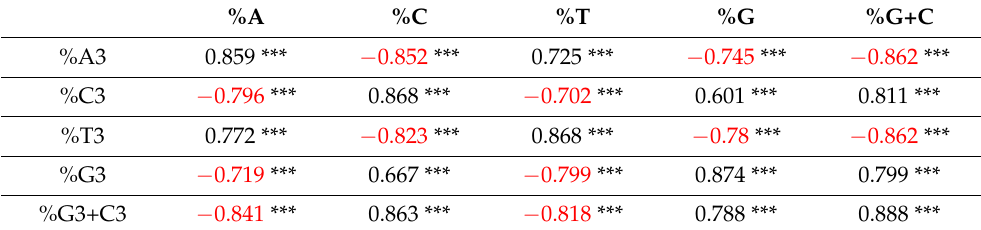
Table 4. Correlation analysis for overall nucleotide composition with composition at third codon position. %A %C %T %G %G+C %A3 0.859 *** − 0.852 *** 0.725